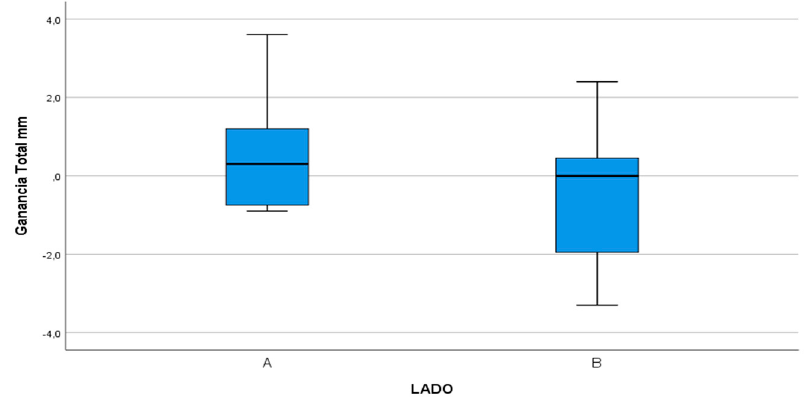
Figure 15. Box-plot representing bone gain in millimeters, measured from the IAN to the bone crest in test group (A) compared with the control group (B).